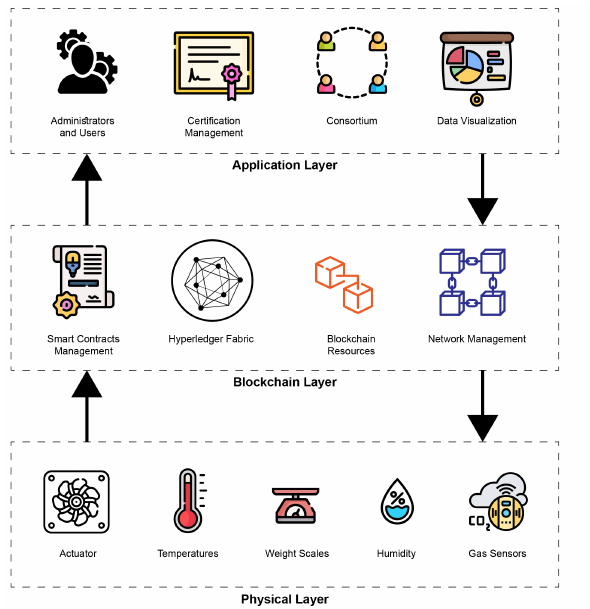
Figure 8. An overview of the Protocol